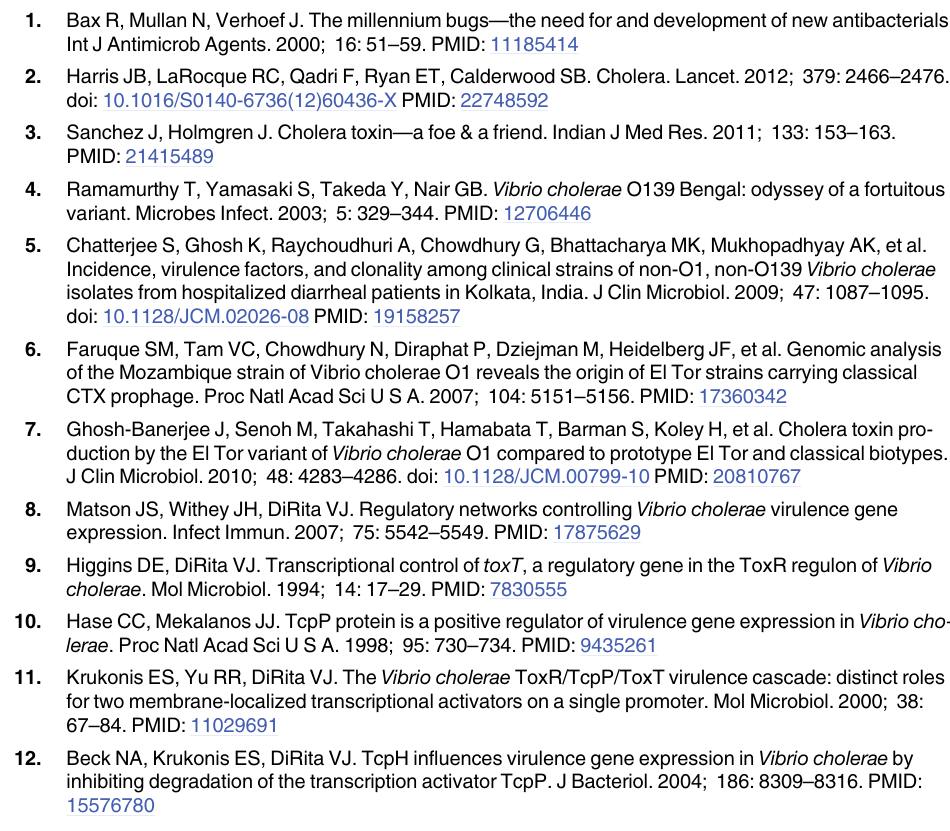
S1 Table. Effect of anethole on the growth of different toxigenic V . cholerae strains. OD Optical density at 600nm. V . cholerae cells were co-cultured with different concentrations of anethole in AKI medium with initial 4 h of stationary followed by 4 h of shaking, and OD each culture was measured by a spectrophotometer. In all cases, values represent the mean ) ± SD of three independent bacterial cultures at respective anethole concentration. (OD 600